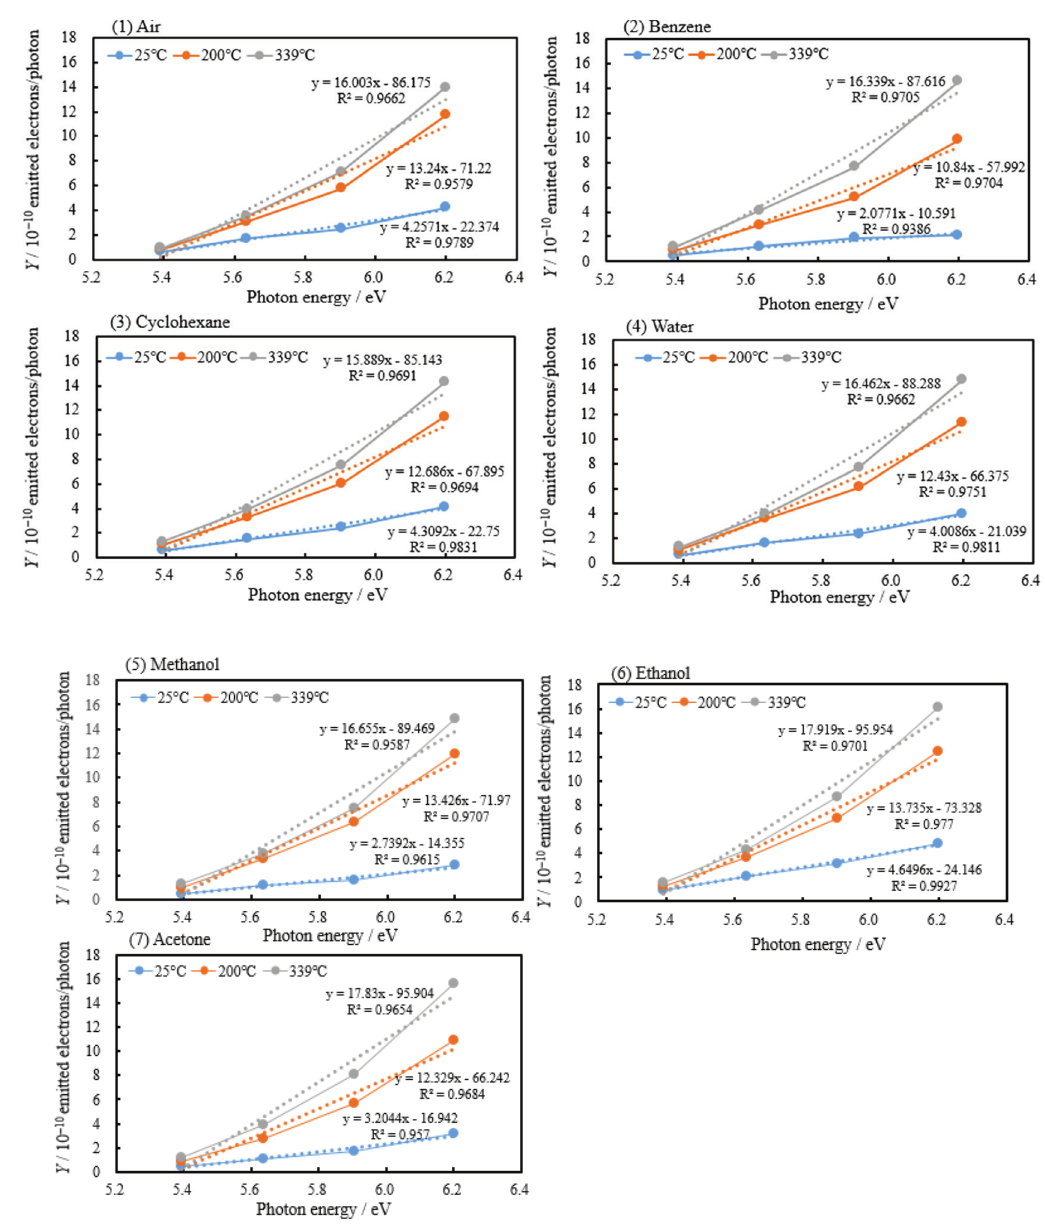
Figure 14. PE quantum yield, Y , as a function of the photon energy at wavelengths of 200 nm (photon energy: 6.199 eV), 210 nm (5.904 eV), 220 nm (5.636 eV), and 230 nm (5.391 eV) during the 300- to 200-nm wavelength scan at 25, 200, and 339 ° C for different environments: (1) air, (2) benzene, (3) cyclohexane, (4) water, (5) methanol, (6) ethanol, and (7) acetone. The Y values are the mean values of the two wavelength scan data.